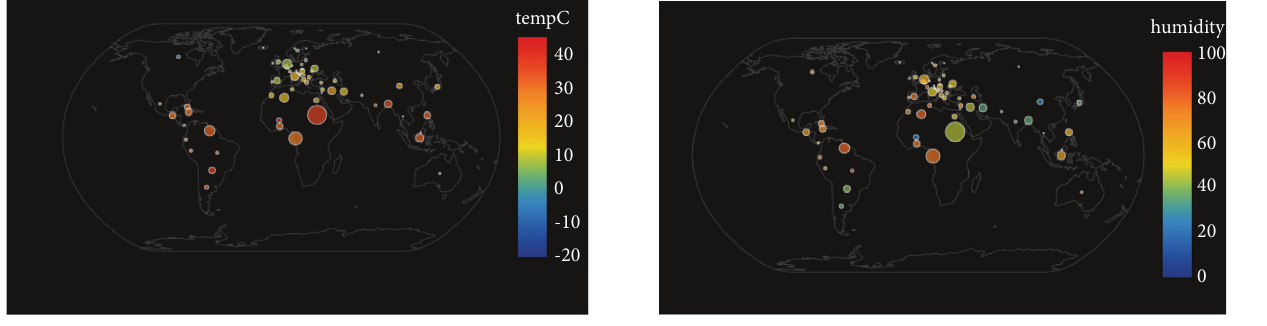
Figure 5: Relationship of temperature with COVID-19 deaths.